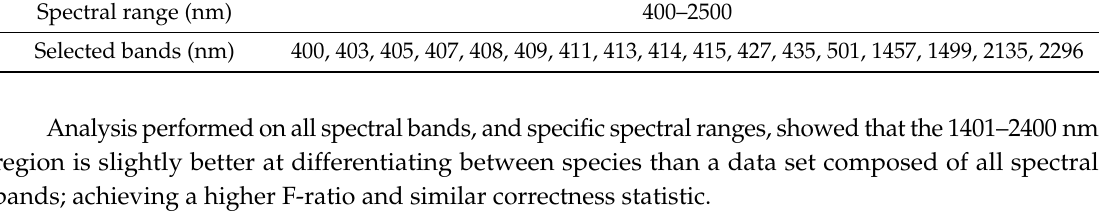
Table 4. Spectral bands providing best separation of species (analysis conducted on whole spectrum; NPMANOVA F-ratio 101 at significance level p < 0.05).